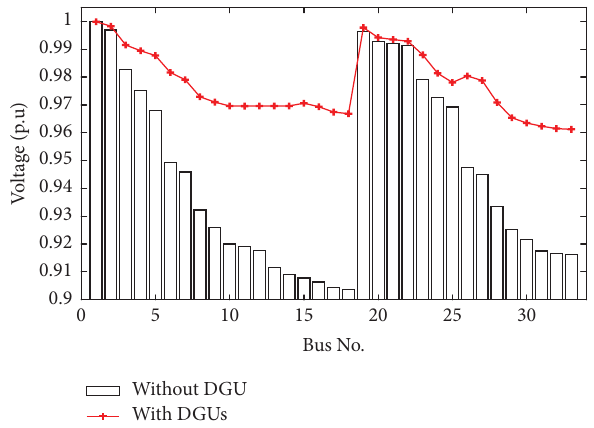
Figure 10: Voltage profle of the IEEE 33-bus system before and after DGUs